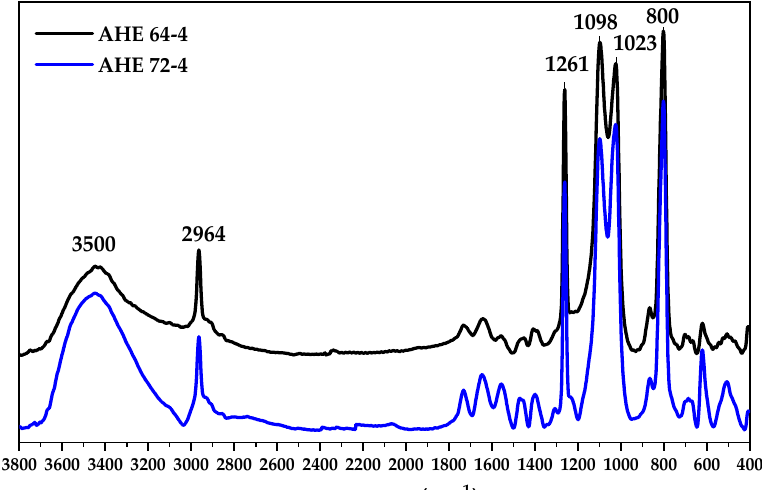
Figure 3. FTIR absorption spectra of the AHE catalysts.